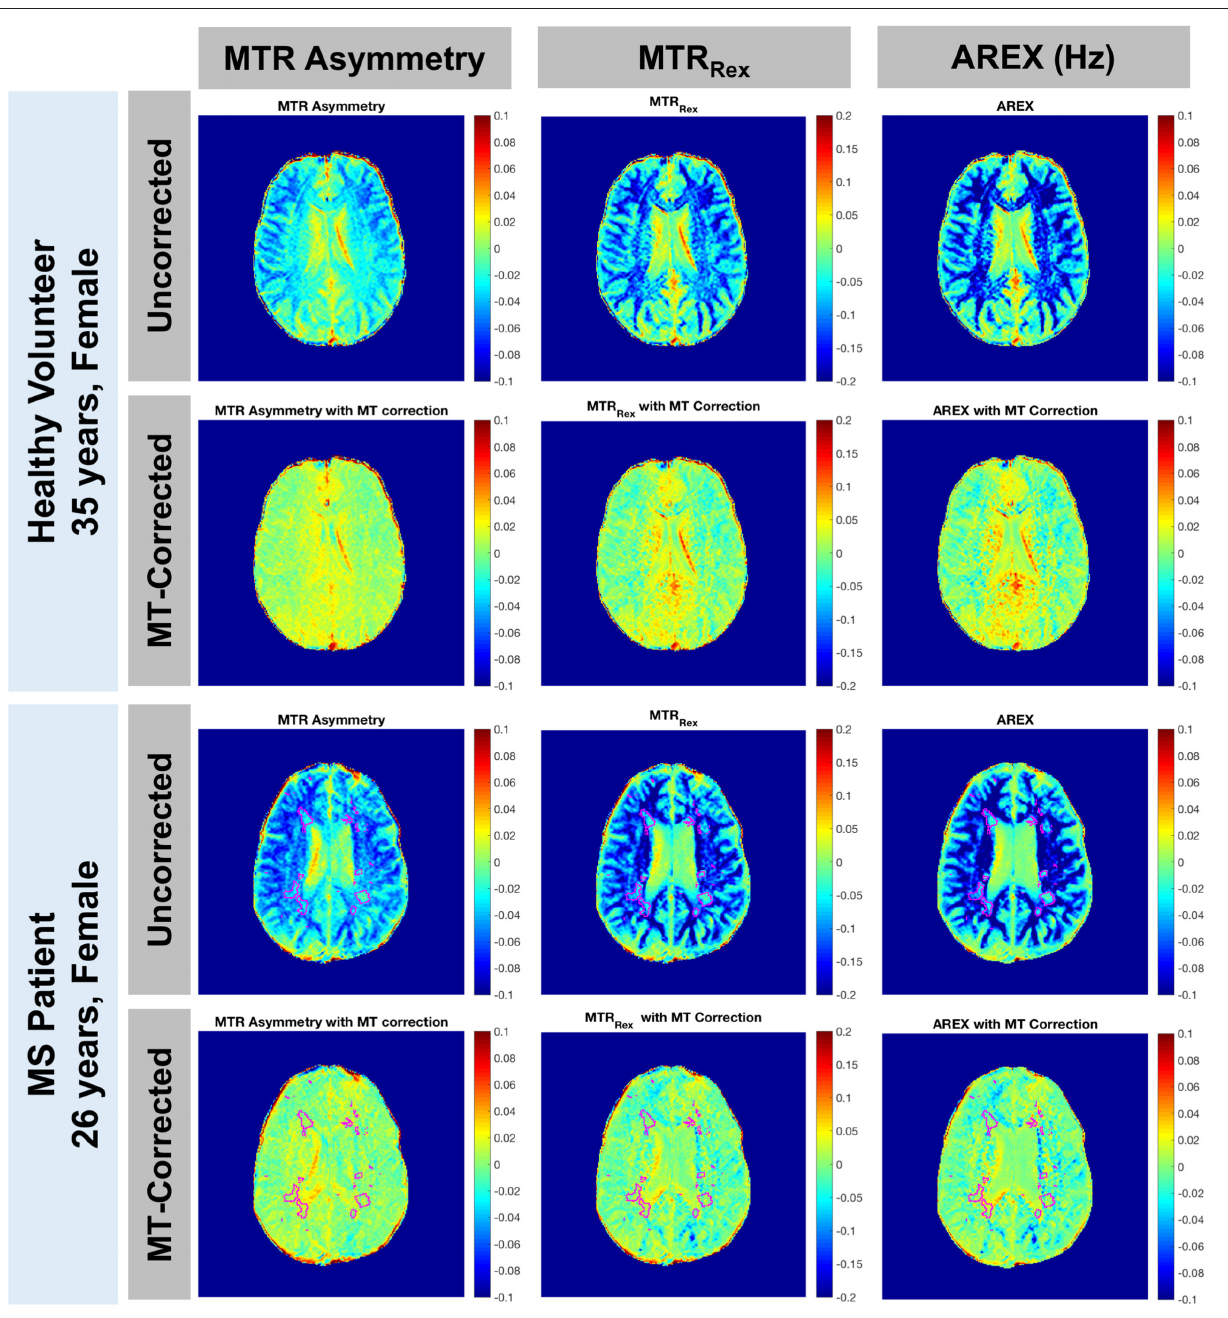
FIGURE 3 | MTR asymmetry, MTR Rex , and AREX maps for 1 ω = 3.0 ppm are shown with and without the MT baseline removal for a representative healthy volunteer (rows 1 and 2: 35-year-old female) and a patient with MS (rows 3 and 4: 26-year-old female, EDSS = 0, duration = 6 years). Before removing the MT contribution, there is a greater difference between GM and WM for all 3 CEST indices (rows 1 and 3). After removal of the asymmetric effect, CEST contrast shifts toward positive values and the difference between GM and WM is reduced but still present (rows 2 and 4). Lesions are outlined in the patient